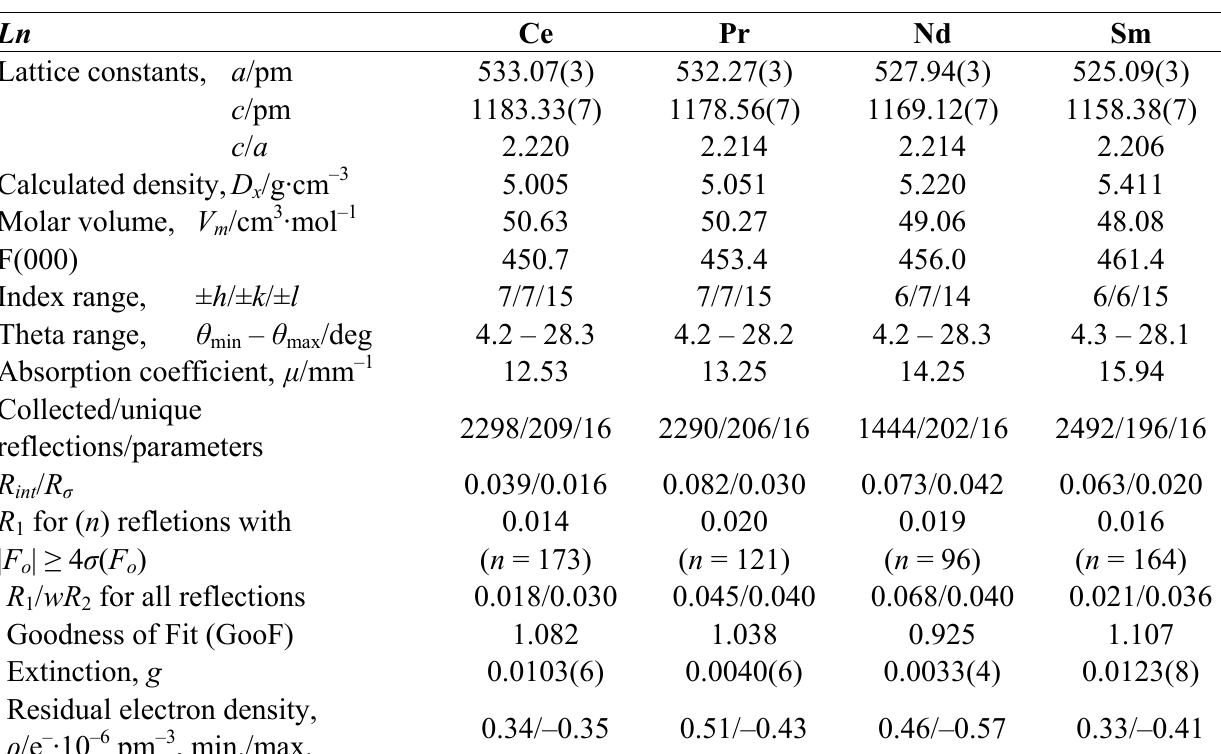
[MoO ] ( Ln = Ce, Pr, Nd, 0.667 4 / a , Z = 4, corrections for 1